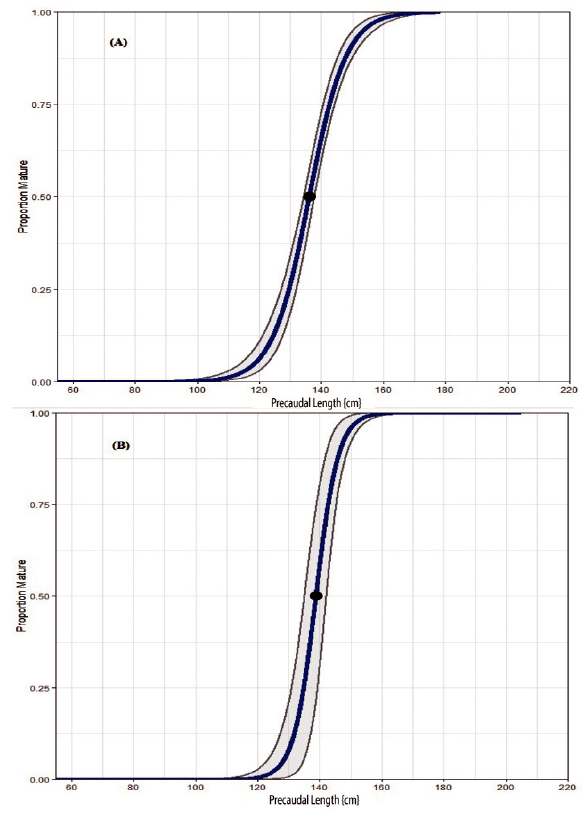
FIGURE 4 | Mean length (CI 95%) at maturity of the thresher sharks Alopias pelagicus ( A ) and A. superciliosus ( B ).